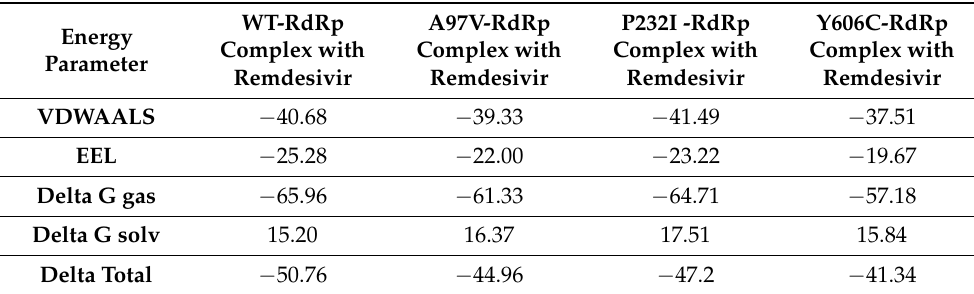
Table 4. Molecular dynamics simulation trajectory-based binding free energies in kcal/mol for wild type and mutants with remdesivir. Y606C-RdRp P232I -RdRp A97V-RdRp WT-RdRp Energy Complex with Complex with Complex with Complex with Parameter Remdesivir Remdesivir Remdesivir Remdesivir VDWAALS −